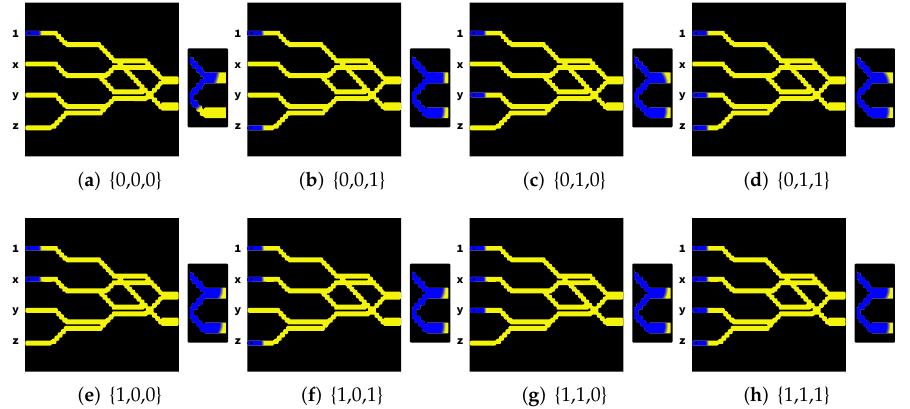
Figure 19. Example of the 3-input OR gate optimized topology. Input ( left ) and result ( right ) time frames for each possible input { x , y , z }